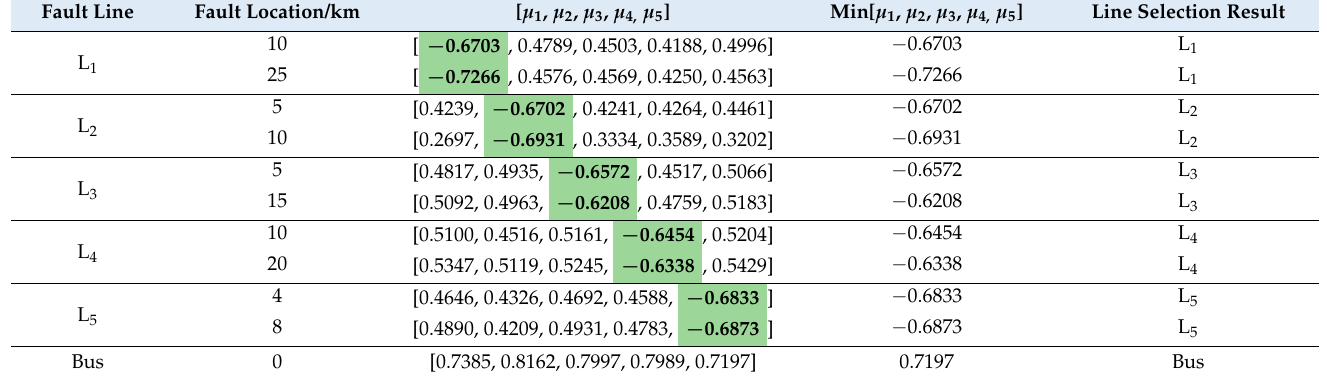
Table 4. The results of feeder identification when R d = 2000 Ω and ϕ =